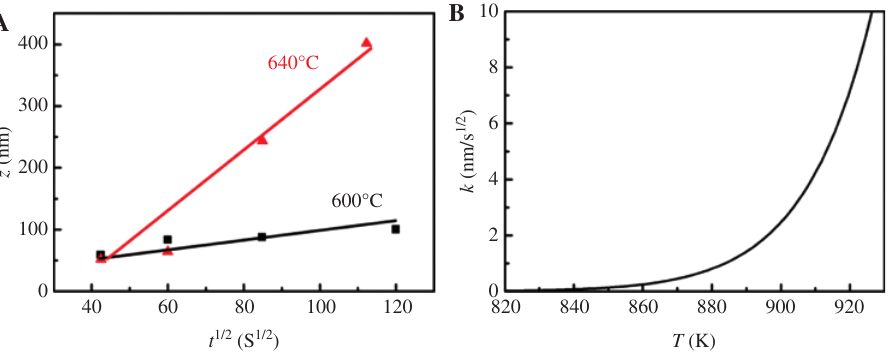
/Al composites: (A) relation of thickness of reaction layer and time; (B) relation of f